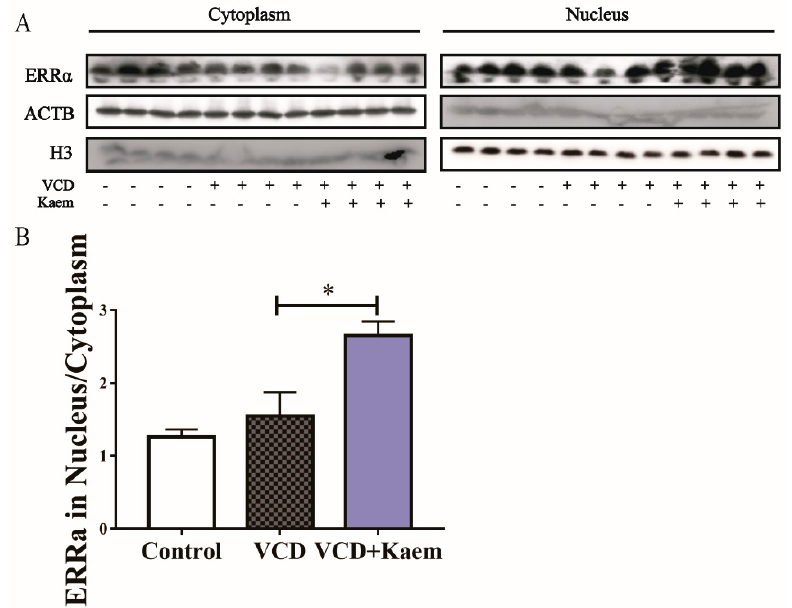
Figure 6. Kaempferol promotes nuclear entry of ERR α in mouse hippocampal. The nuclei and cytoplasm of hippocampus cells were isolated in the control group, VCD group and kaempferol treatment group. Then, the levels of ERR α protein in the nucleus and cytoplasm were tested ( A , B ). Ratio of ERR α in the nuclei and cytoplasm were calculated. One-way ANOVA analysis was used for Tukey’s multiple comparisons test. Data are represented as mean ± SEM, n = 8 per group; * p <